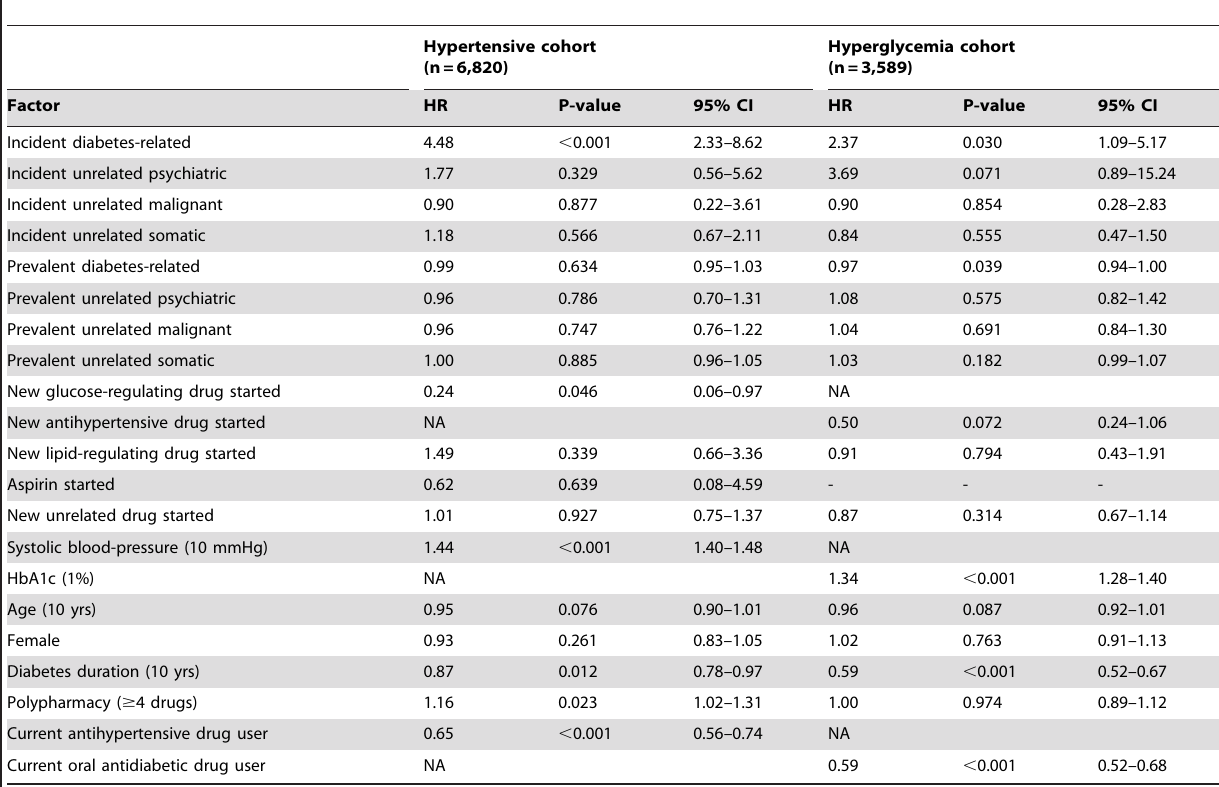
Table 4. Results of the Cox proportional hazard models for the hypertensive and hyperglycemia cohorts.